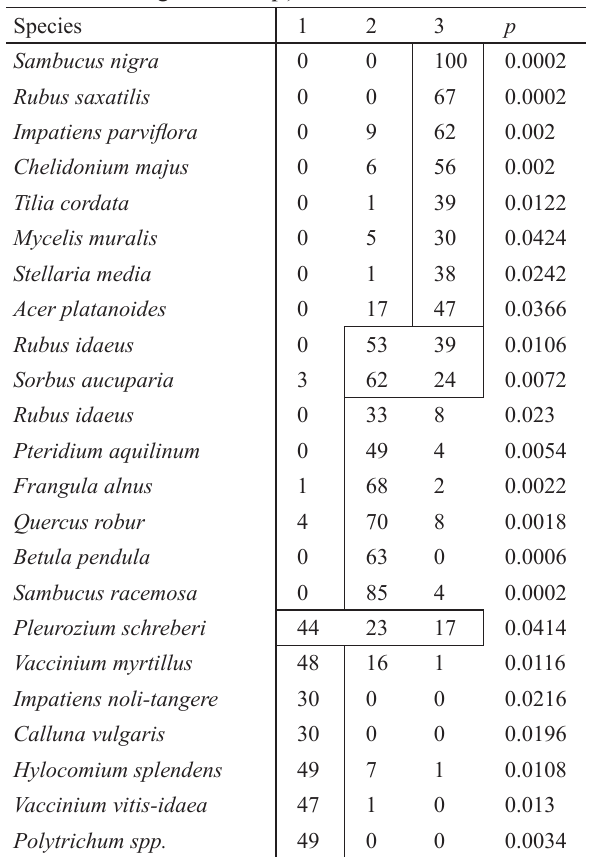
Table 2. Plants species indicator values of the analysed groups of forest communities: Natural forests (1); Sambucus racemosa (2); Sambucus nigra (3) and significance ( p ).